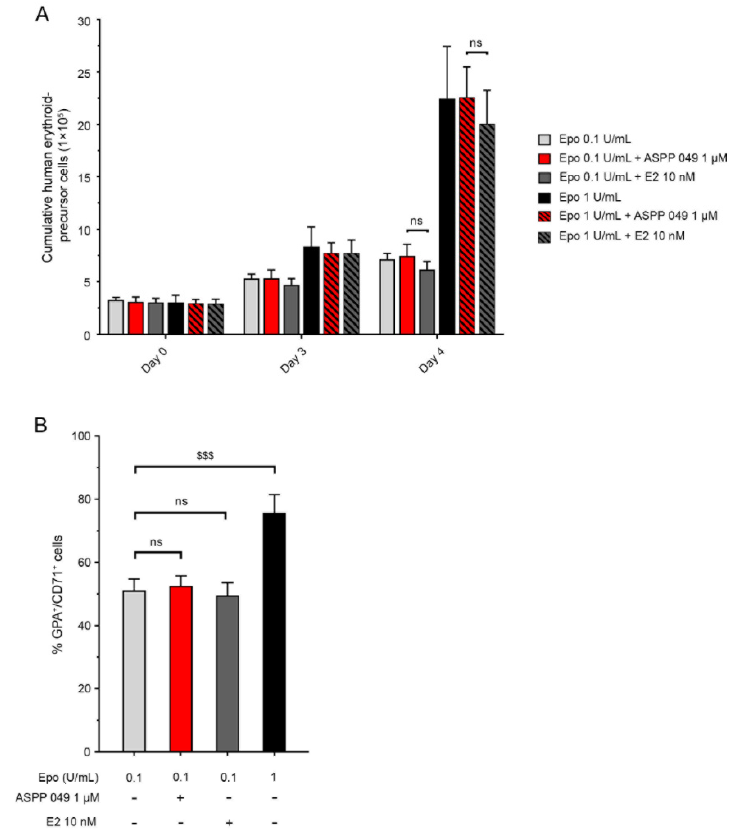
Figure 5. ASPP 049 could not stimulate erythropoiesis of CD36 + erythroid precursor cells. CD36 + cells sorted from CD34 + HSCs cultured in erythroid medium were treated with 1 μ M ASPP 049 and 10 nM E2 in the presence of 0.1 or 1 U/mL of Epo. Proliferation of CD36 + cells was observed by ( A ) trypan blue exclusion assay and expression of immature erythrocyte markers (GPA + CD71 + ) was de ‐ tected by ( B ) flow cytometry analysis. All data are expressed as mean ± SEM ( n = 3). E2, 17 β‐ estra ‐ diol; Epo, erythropoietin; HSCs, hematopoietic stem cells; ns, non ‐ significant. $$$ p <